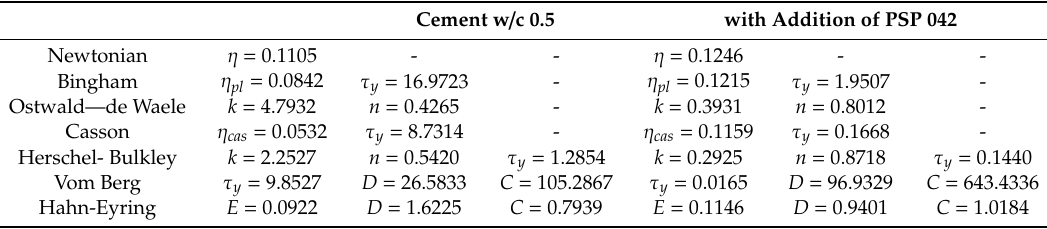
Table 3. Fluid rheological parameters obtained from Rheosolution 4.0 for cement slurry samples (with and without adding